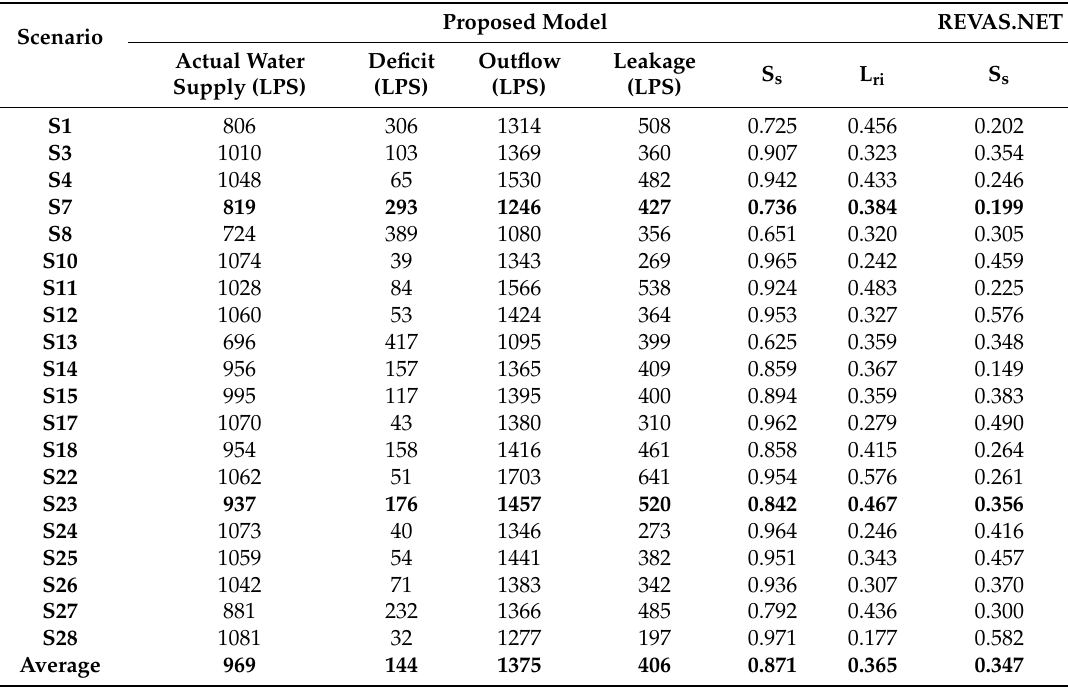
Table 5. Comparison results between proposed model and